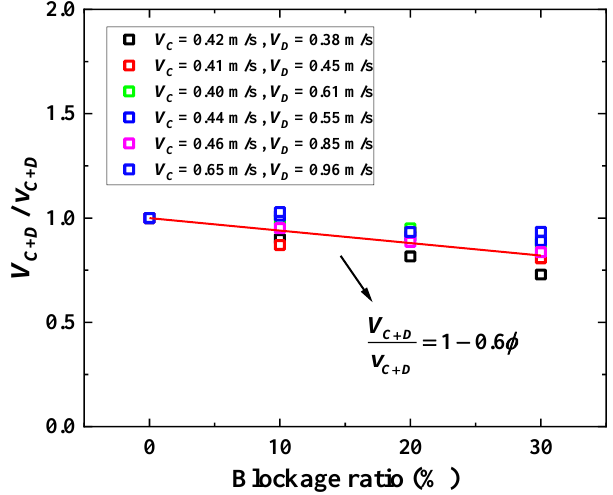
Figure 13. Variation in velocities with blockage ratio.